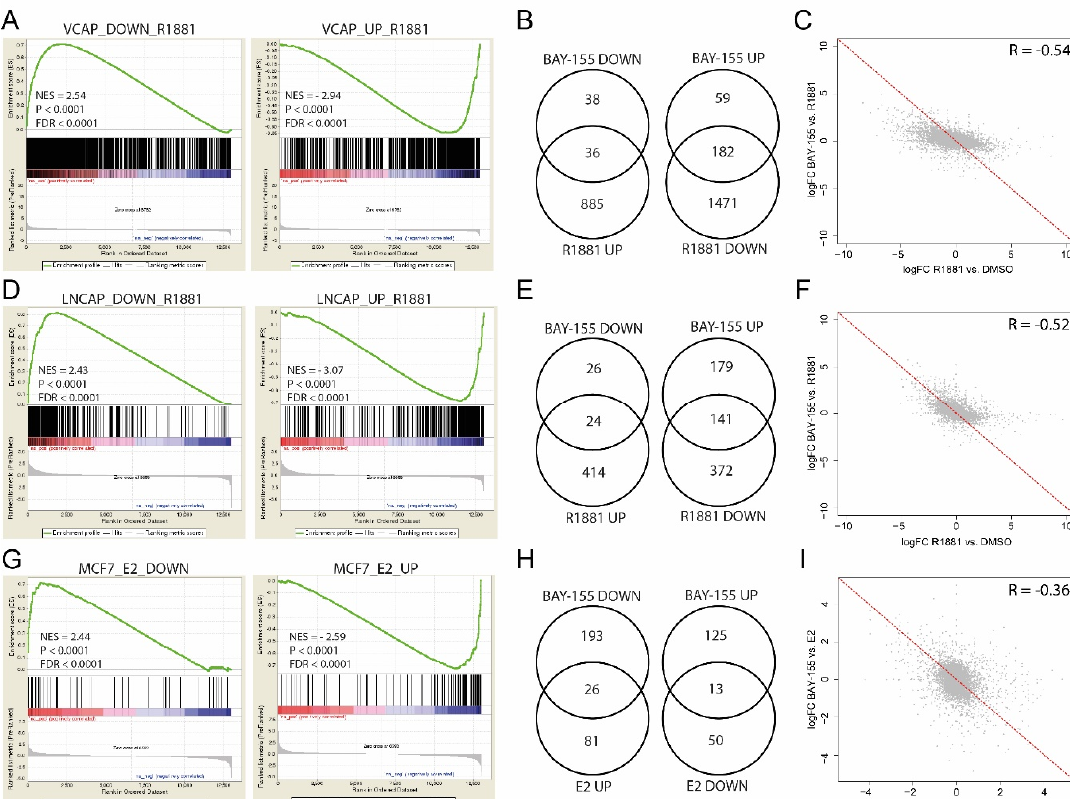
Figure 4. Differential gene expression effects of BAY-155 in prostate and breast cancer models. ( A ) and ( D ) Gene Set Enrichment Analysis (GSEA) of androgen up-regulated and down-regulated genes after R1881-induction of BAY-155 treated VCaP ( A ) and LNCaP ( D ) cells. ( B , E ) Venn-diagrams representing the overlap between BAY-155 and R1881 differentially regulated genes in VCaP ( B ) and LNCaP ( E ) cells. ( C ) and ( F ) LogFC correlation of R1881-induced gene expression changes and BAY-155 treatment induced gene expression changes in VCaP ( C ) and LNCaP ( F ) cells. ( G ) GSEA of estrogen up-regulated and down-regulated genes after E2-induction of BAY-155 treated MCF7 cells. ( H ) Venn-diagrams representing the overlap between BAY-155 and E2 differentially regulated genes in MCF7 cells. ( I ) LogFC correlation of E2-induced gene expression changes and BAY-155 treatment induced gene expression changes in MCF7 cells. Genes with Log2FC > 1 or < −1 and FDR < 0.1 were considered significantly changed.